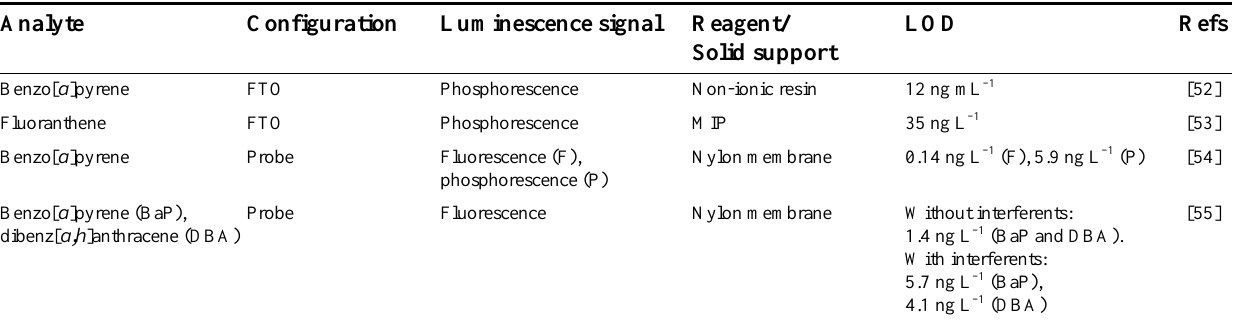
Table 2. Luminescence sensors for organic pollutants in natural